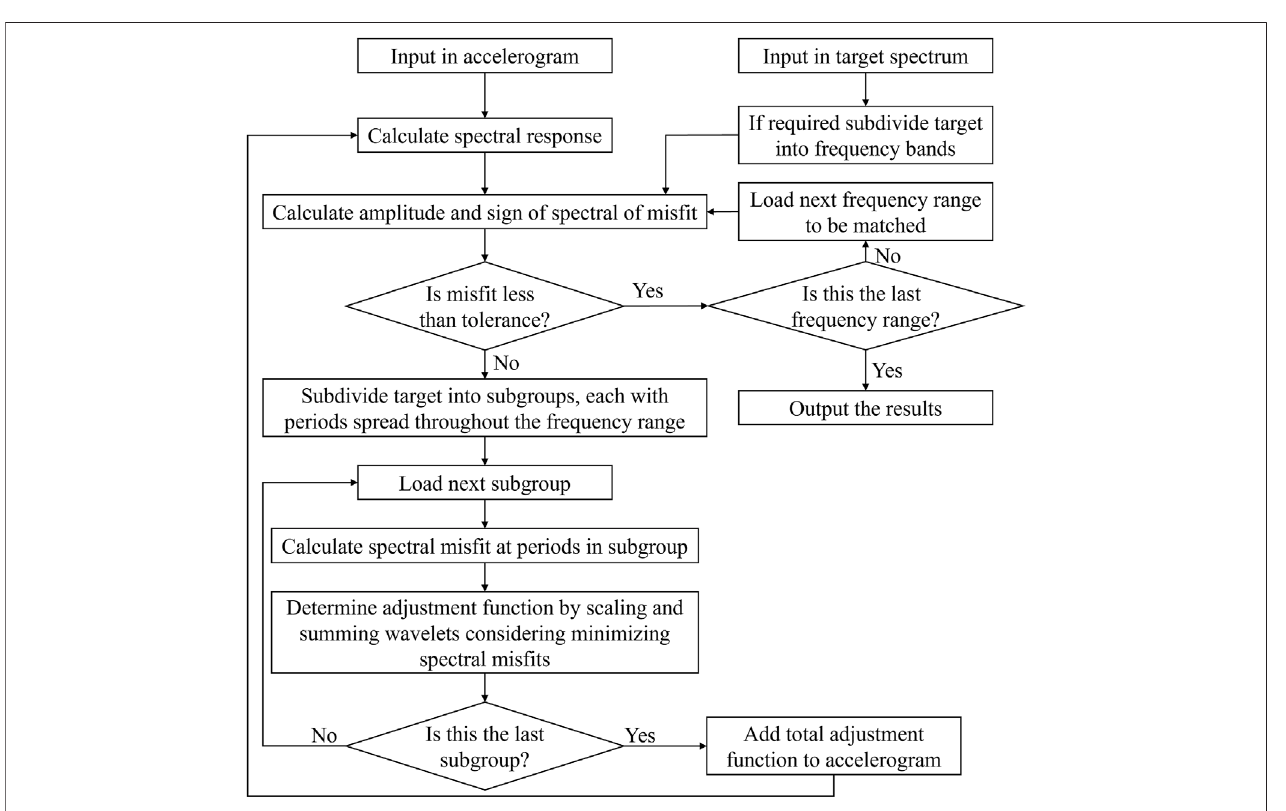
FIGURE 1 | General fl owchart for wavelet-based spectrum matching (Hancock et al., 2006).